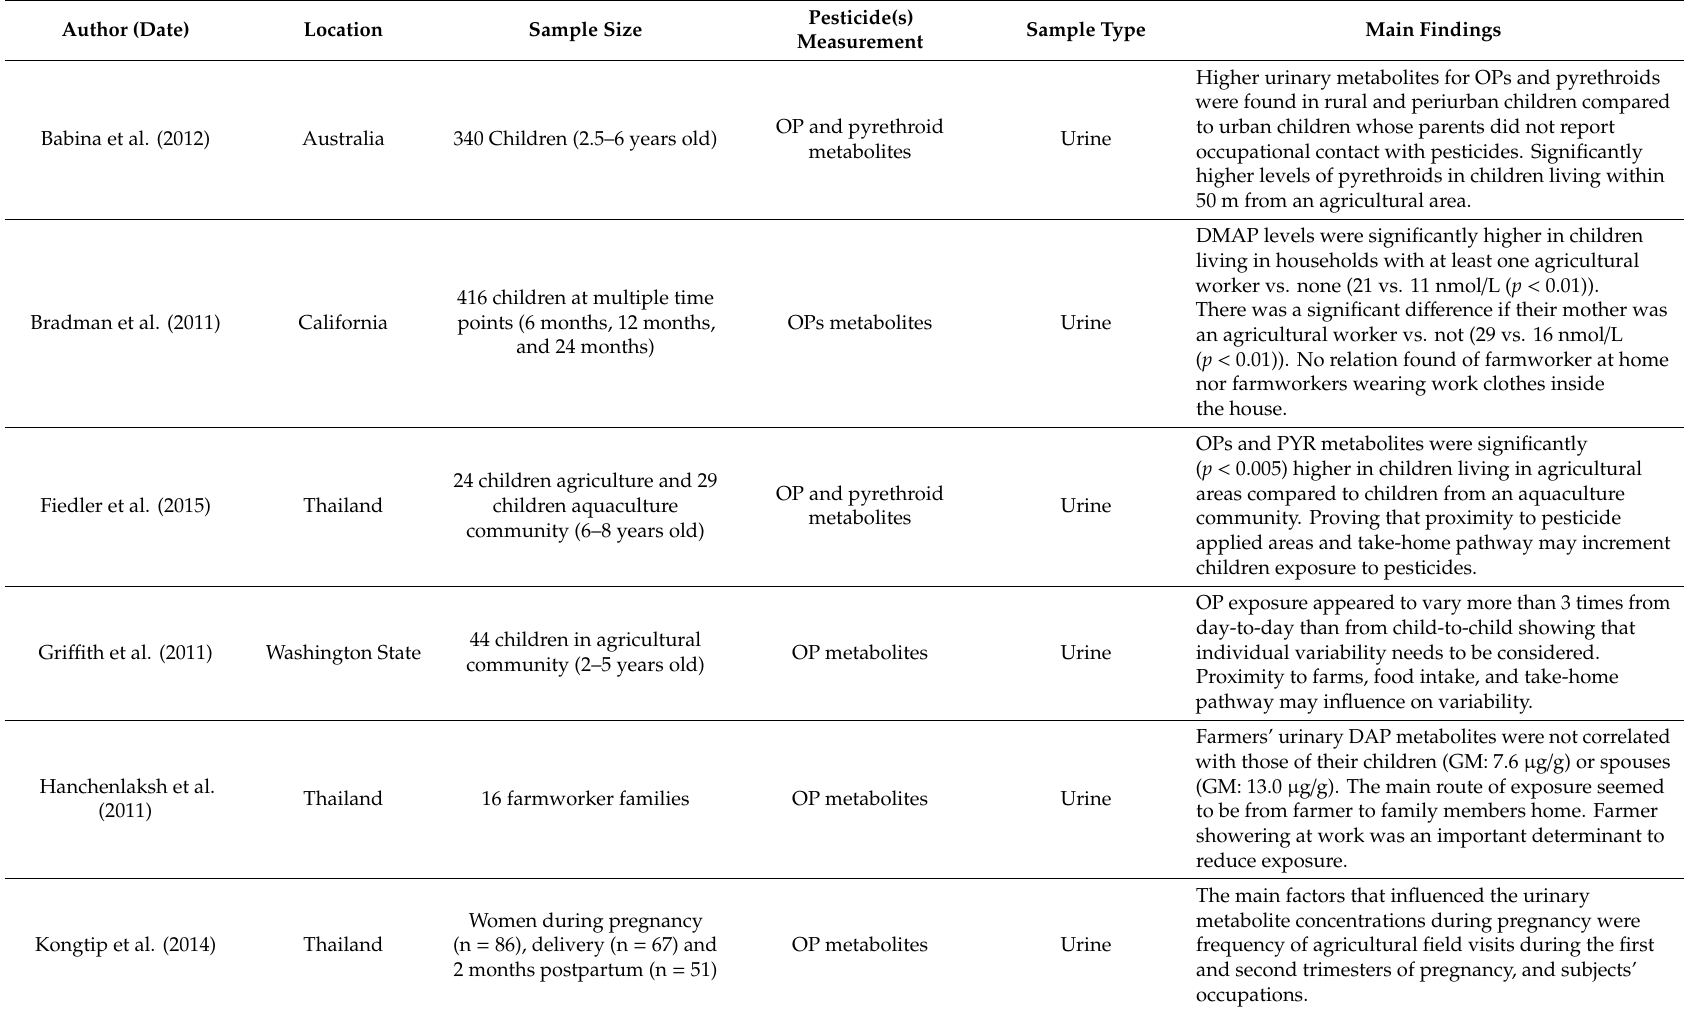
Table 2. Literature review summary on take-home pathway of pesticide exposure—urine